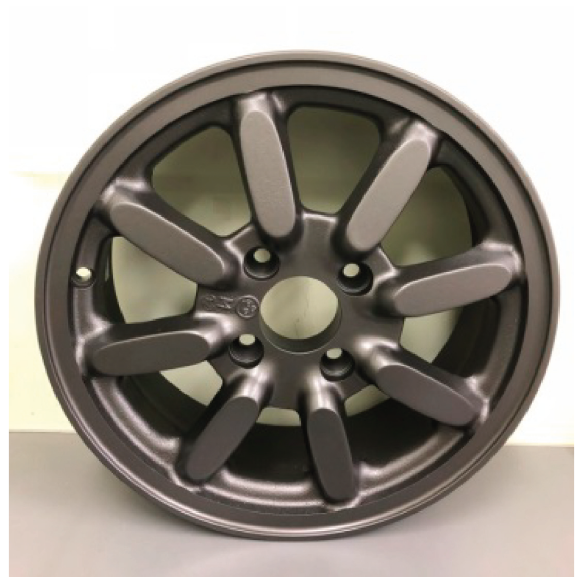
Figure 7: Magnesium alloy wheel.